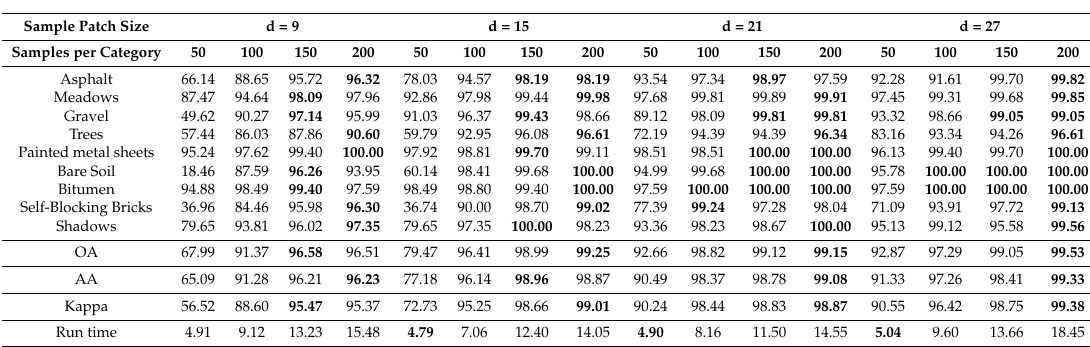
Table 12. Classification accuracies obtained by the proposed spatial-spectral FFPNet (with sample patch sizes of d = 9, 15, 21, and 27) for the UP dataset. The values in bold are the best under different sample patch sizes. All results are the average of three runs with maximum epoch = 200 and mini-batch size =